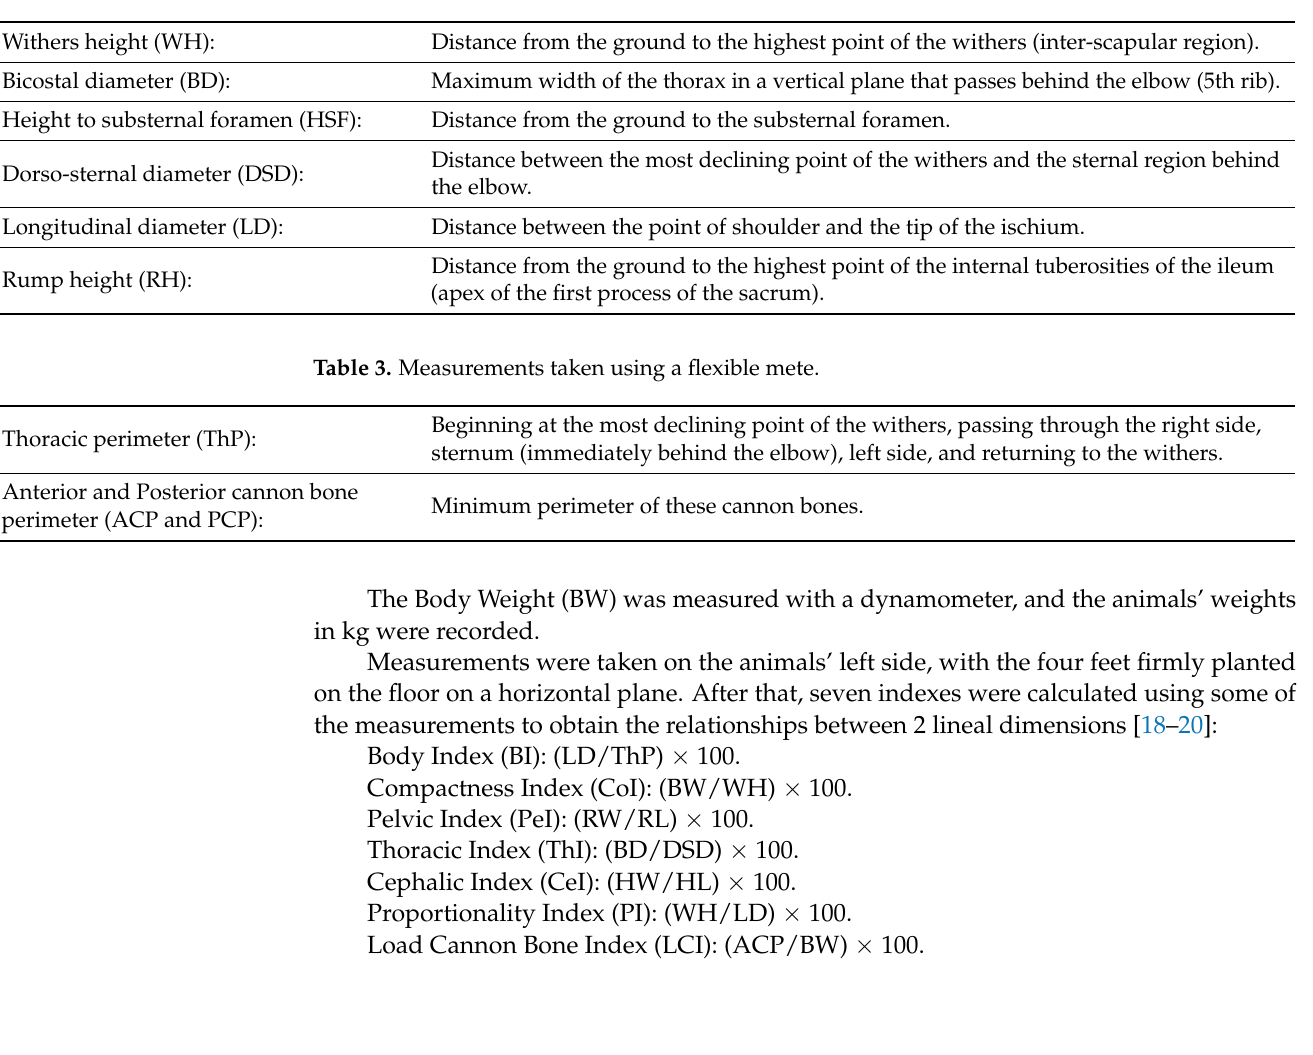
Table 2. Measurements taken with the aid of a zoometric stick.